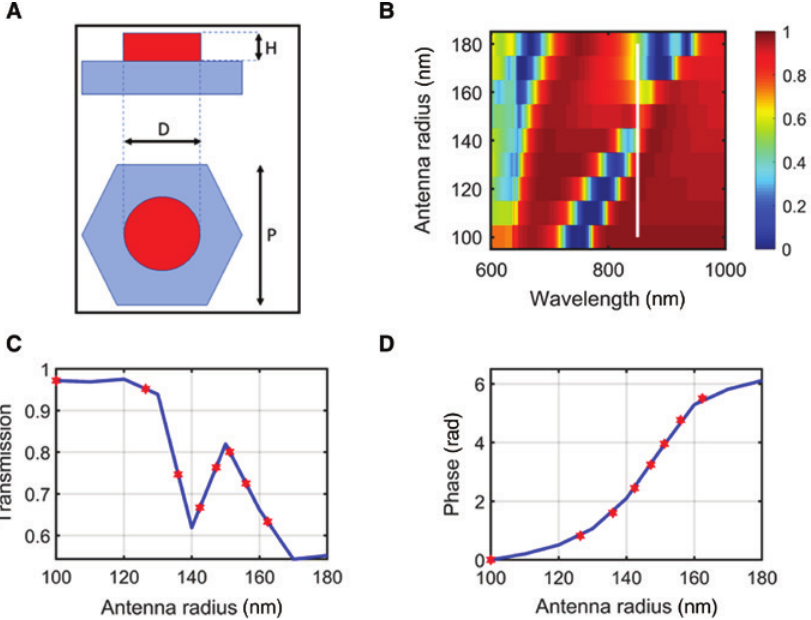
Figure 2: Response of Huygens a-Si antenna array on glass. (A) Nano-antenna unit cell design. P = 500 nm, H = 140 nm, and D is in the range of 200–328 nm. (B) Transmission as a function of wavelength and antenna radius. White vertical line is the section along which graphs C and D are drawn. (C) Transmission at 850 nm as a function of antenna radius. (D) Phase at 850 nm as a function of antenna radius. Red markers are at the location of the eight antenna radii used in our